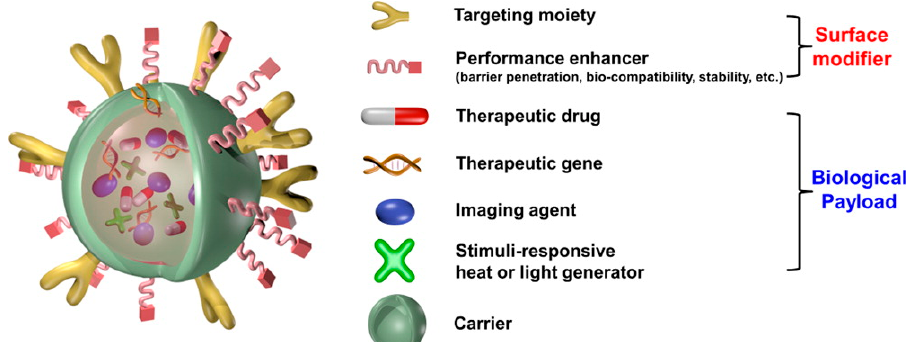
Figure 2. Schematic illustration of a multifunctional nanocomposite. Image reprinted with permission from [23]. Copyright (2015) American Chemical Society.